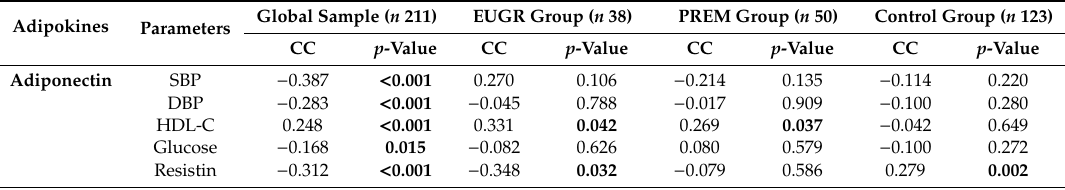
Table 4. Results of the correlation analysis among adipokines and anthropometry, blood pressure, and biochemical parameters in the global sample and those in children with a history of prematurity and extrauterine growth restriction (EUGR group), those with prematurity without EUGR (PREM group) and healthy prepubertal children (control